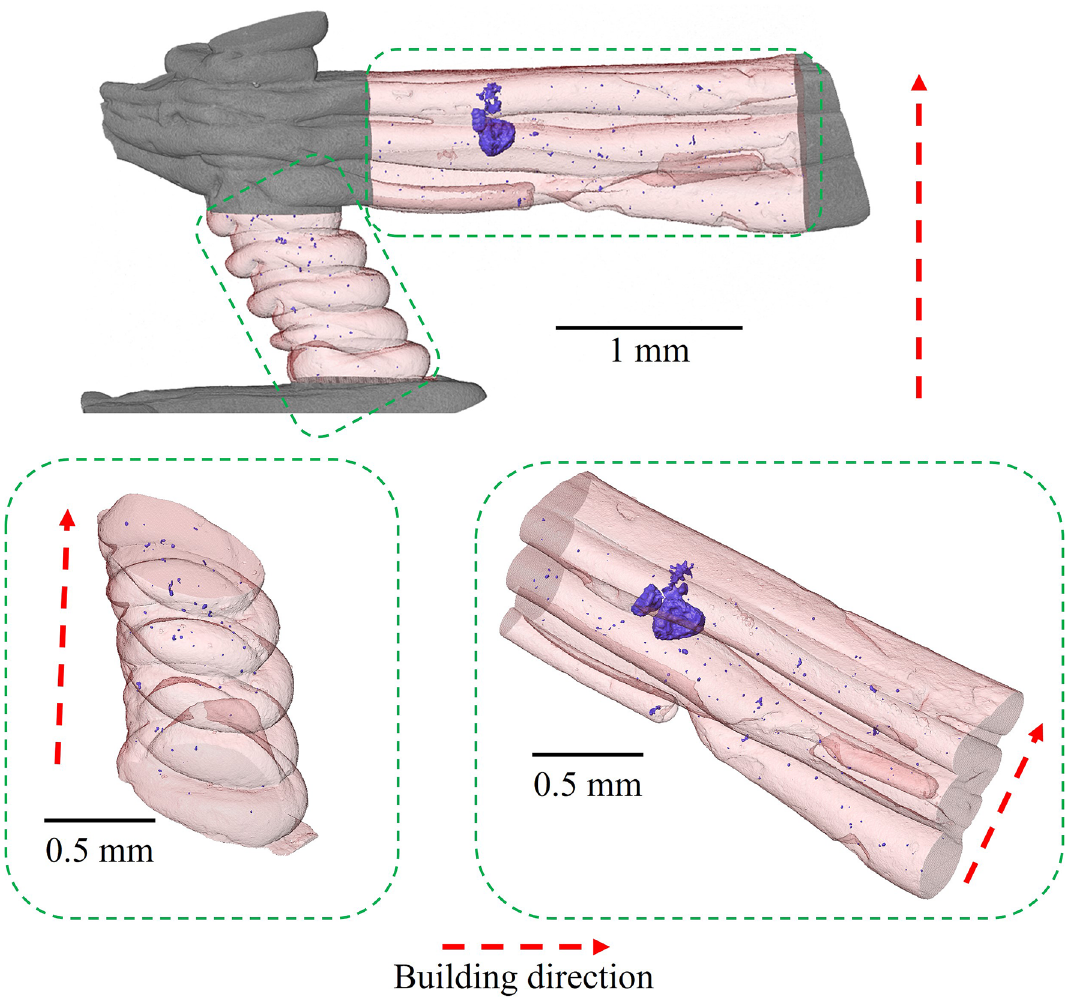
Figure 3. Characteristic defects and internal porosity (rendered purple) observed by µCT (Avizo Standard segmentation) in the rib/struts of periodic cells.